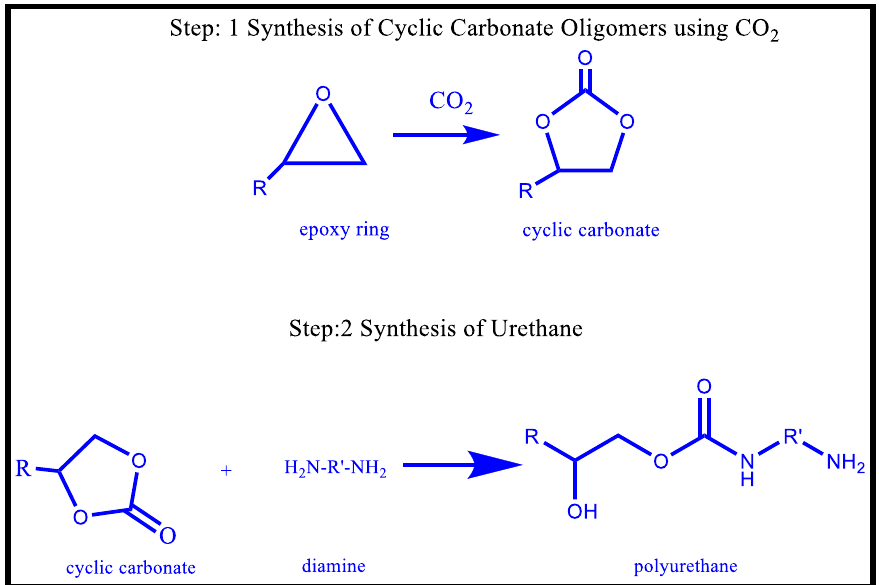
Figure 11. Aminolysis for the synthesis of NIPU [109].